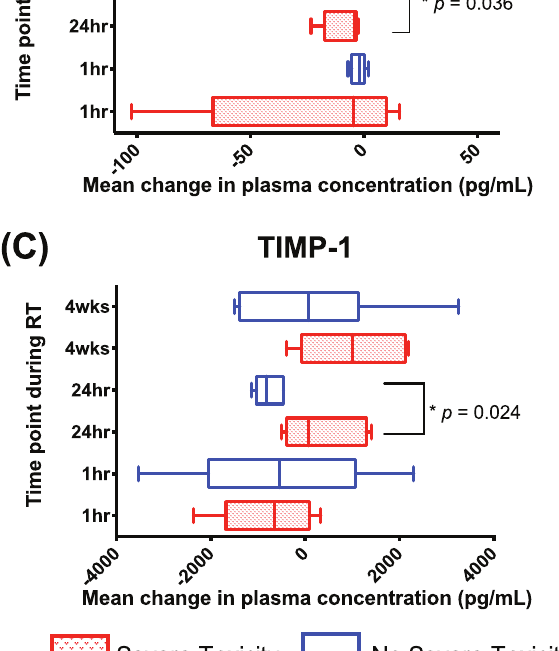
Figure 6. Box and Whisker plot demonstrating median population change of cytokine levels from baseline for Eotaxin, IL-6 and TIMP-1 during treatment delivery, with 5 th – 95 th centiles. Statistically significant differences between patients with severe respiratory toxicities [shaded boxes] and those without [open boxes] are highlighted with associated p - values.